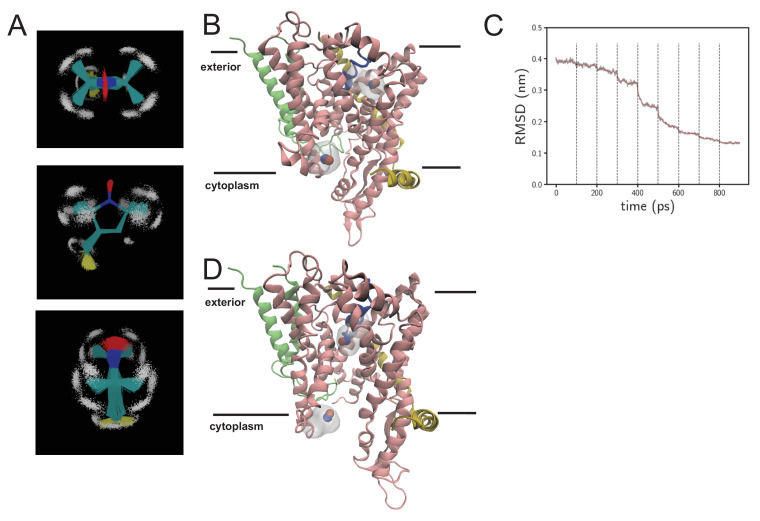
MD data in support of EPR DEER analysis.(A) Views of parameterised spin-label (MTS; S-(1-oxyl-2,2,5,5-tetramethyl-2,5-dihydro-1H-pyrrol-3-yl)methyl methanethiosulfonate). The molecule is shown as lines and coloured according to atom type, with hydrogens shown as white points. Multiple simulation frames from 100 ns of simulation are overlaid and reveal the geometric stability of the molecule. (B) Snapshot from the resting spin-labelled SecYEG simulation, showing the protein as cartoon, coloured as per Figure 1C. The NO of the spin labels are shown as red and blue spheres, with the surface of the entire spin label shown in light shade. (C) RMSD over time as the systems from panel B are subjected to targeted MD. Here, the alpha carbons are compared to the alpha carbons of SecY from the opened SecA-SecYEG complex (Zimmer et al., 2008). Each dotted black line represents the addition of a stronger restraining force. After 800 ps, the RMSD is stable and very low, and the channel is now in an opened conformation. (D) As panel B, but of the opened channel. Upon channel widening, the MTS is able to flip into the channel, resulting in a much shorter predicted DEER distance.